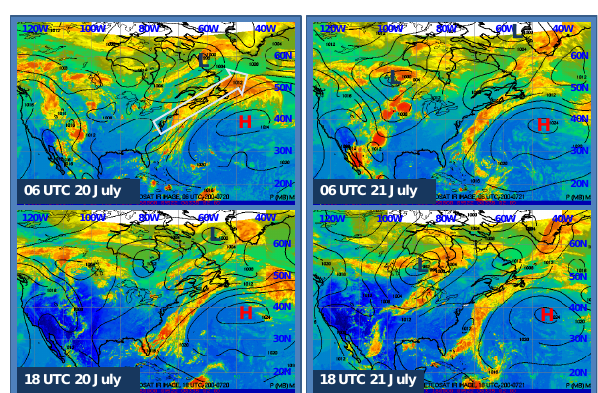
Biogenic emission BEIS 3.13